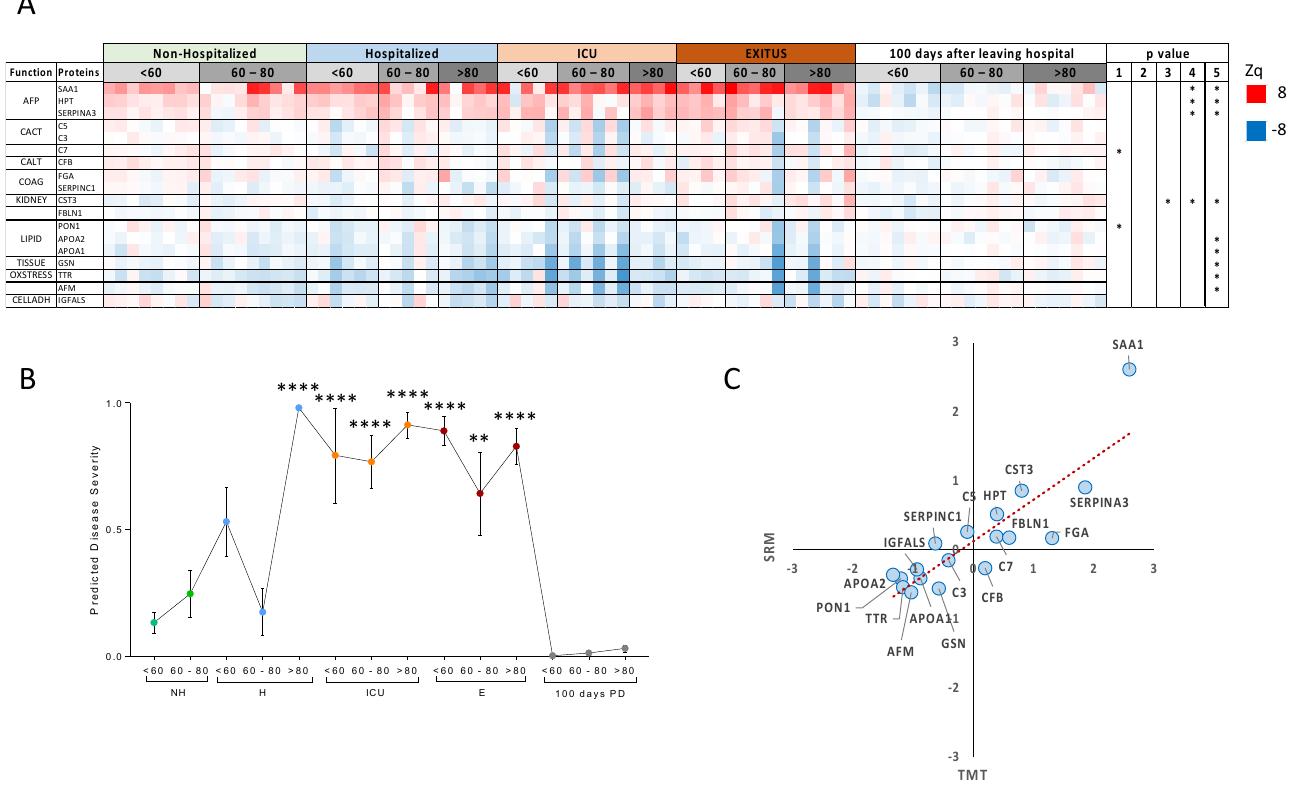
Figure 4. Proteins monitored by SRM. ( A ) The heatmap shows protein abundance changes (Zq) normalized by the average values of the 100 days after leaving hospital patient group. Up-regulated proteins are shown in red and down-regulated proteins in blue. Statistical significance of changes ( p -value) is calculated using two-tailed Student’s t -test (1 = Non-Hospitalized vs Hospitalized, 2 = Hospitalized vs ICU, 3 = ICU vs EXITUS, 4 = Non-Hospitalized vs EXITUS, 5 = Exitus vs 100 days after patient discharged). ( B ) Prediction of disease severity using a logistic regression model. The model was trained using the same proteins as in Figure 3. ( C ) Protein quantification from TMT and SRM experiments. Protein quantification is represented as the average difference of Zq values be- tween Non-Hospitalized and EXITUS patients. Statistical significance ( p -value) is calculated using one-way ANOVA (** p < 0.01, **** p < 0.0001 and all the comparisons refer to <60 years-old non- hospitalized patients.